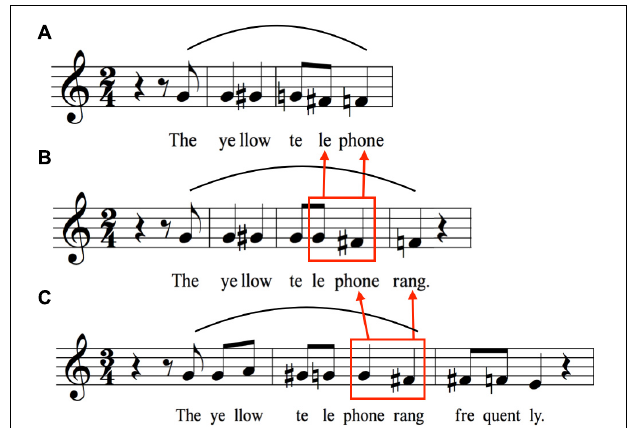
FIGURE 4 | Expansion to from longer sentences starting with “The yellow telephone”. As words are added to the end of the sentence, declination is suspended on the last syllable of the previous sentence such that the characteristic drop between the penultimate and final syllables can serve to mark the end of the sentence at the newly added final word. (A) Melodic pattern for “The yellow telephone rang.” (B) Melodic pattern generated by adding the word “rang” to the end of the sentence in (A) . The red box highlights the difference in pitch height between the syllables “le-phone” in (A,B) , demonstrating the suspension of declination occurring on these syllables in (B) . (C) Melodic pattern generated by adding the word “frequently” to the end of the sentence in (B) . The red box around “phone rang” highlights the difference in pitch height between these syllables in (B,C) . The point of suspension of declination has moved from “phone” to “rang” in (C)